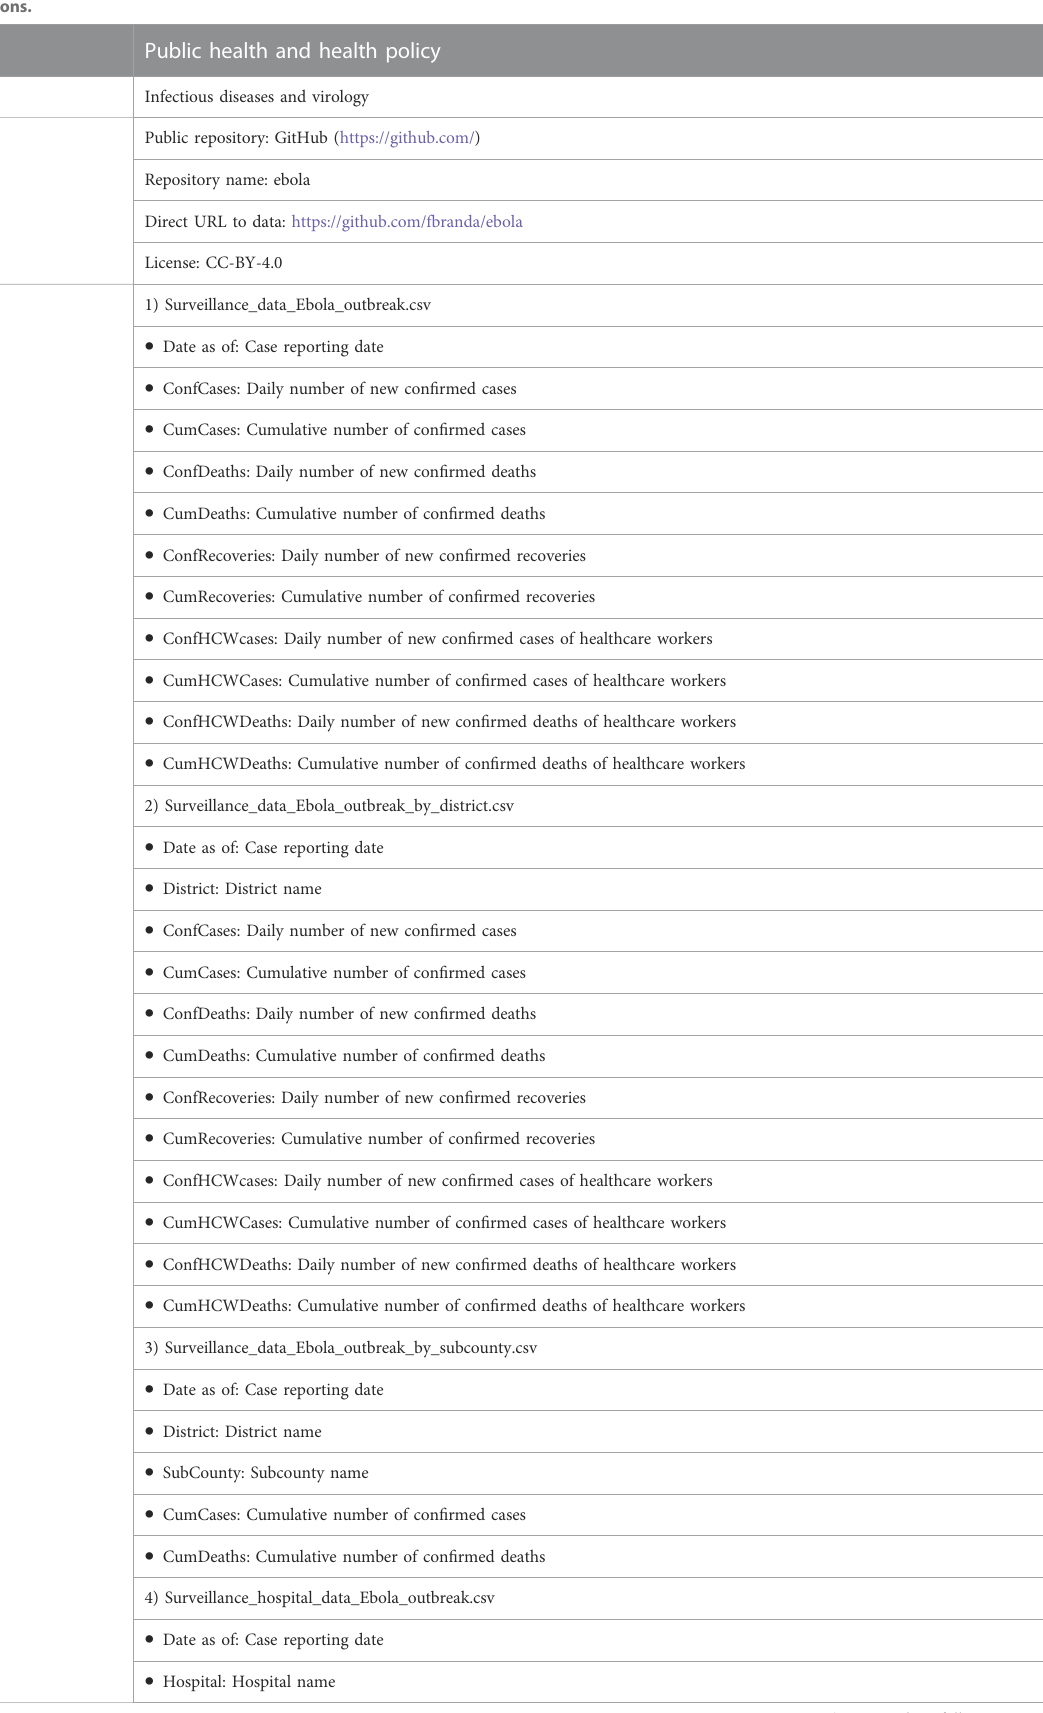
TABLE 1 Database speci fi